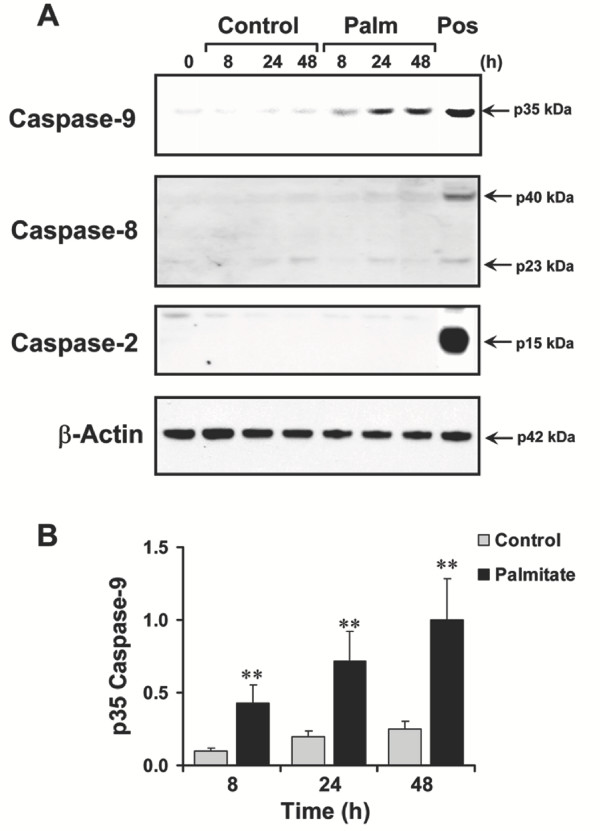
Palmitate stimulates cleavage of caspase 9 in HMC. (A) HMC treated with palmitate were analyzed for caspase cleavage by Western blotting of total HMC lysates with antibodies that recognize the cleavage products of human caspase 9 (p35), caspase-8 (p40 and p23), and caspase-2 (p15). For a positive control in each experiment, cells were treated for 8 h with an agent known to be a strong stimulus for the caspase in question: caspase 9, staurosporine 1 μM; caspase 8, etoposide 25 μM; and caspase 2, camptothecin 6 μM. The blots were reprobed with β-actin to ensure equal protein loading. (B) Densitometric analysis (mean ± SEM) of the p35 caspase 9 fragment from 3 independent experiments. **, P < 0.01 by ANOVA versus control.